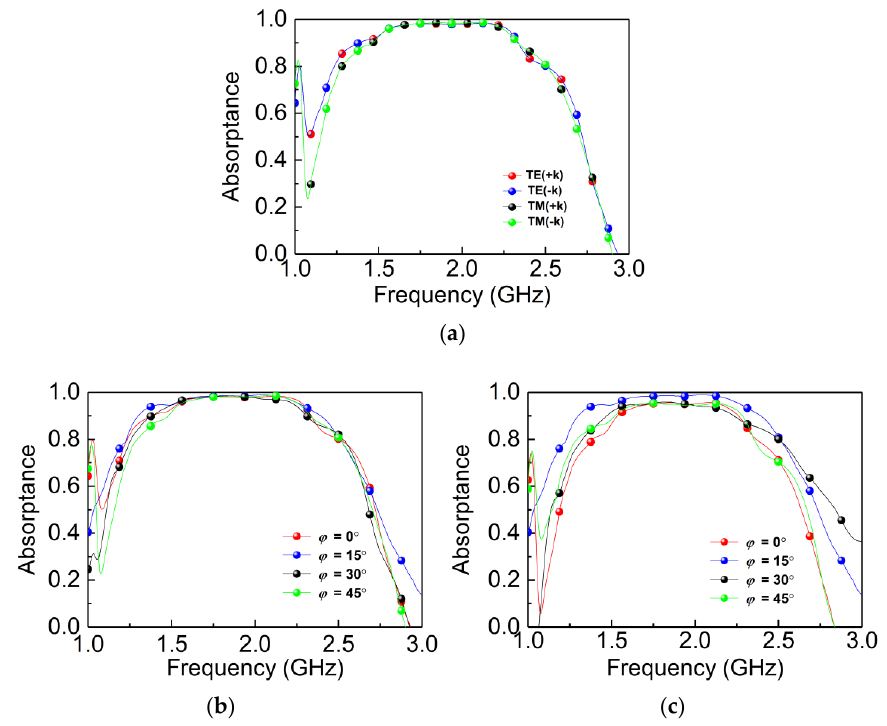
Figure 12. Measured absorption properties of the designed absorber. ( a ) Forward and backward absorptance in TE and TM mode; ( b , c ) absorptance responses of TE and TM modes vary with fre- b , c ) absorptance responses of TE and TM modes vary quencies at different polarization angles. absorptance in TE and TM mode; (